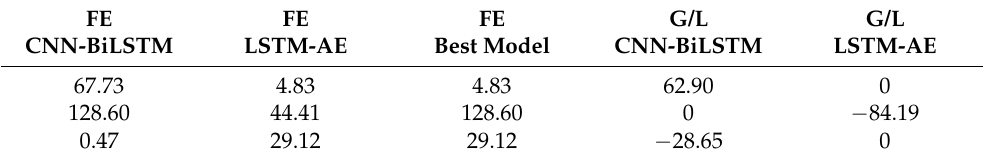
Table 11. An example of Gain/Loss of SENERGY over two models.